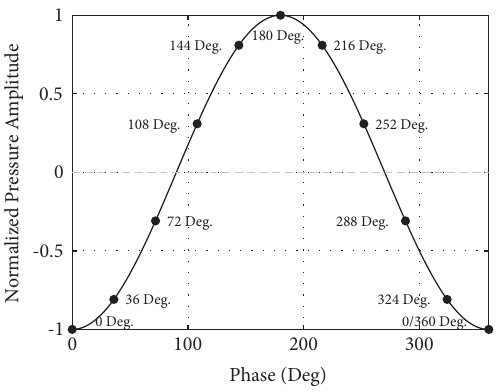
Figure 8: Phase definition for the thermoacoustic instability